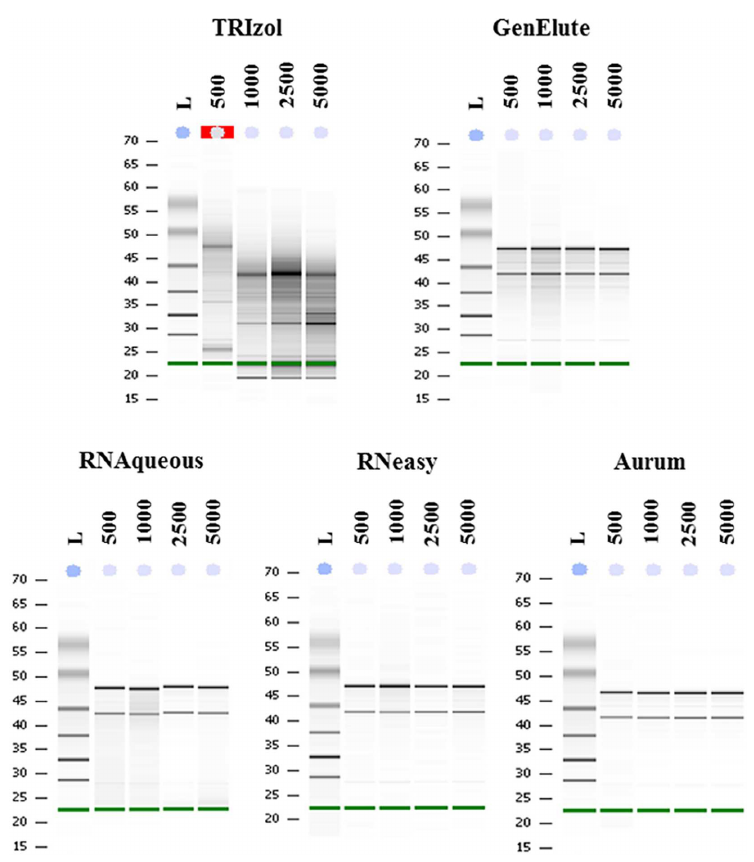
Fig 1. Bioanalyzer Agilent electrophoresis runs. Examplesof representativeBioanalyzer Agilent electrophoresis runs for the five different methodsappliedfor RNA extractions from P . lividus embryos: TRIzol, GenElute ™ MammalianTotal RNA MiniprepKit (Sigma-Aldrich), RNAqueous ® Micro Kit (Ambion from Life Technologies), RNeasy ® Micro Kit (Qiagen) and Aurum ™ Total RNA Mini Kit (Biorad). Four different numerical amounts of embryos were used for RNA extraction: 500, 1000, 2500 and 5000 embryos. The ladder(L) is reportedin the first laneof each run. The green bandat the bottom of each panel is the RNA 6000 Nano Marker (Agilent RNA 6000Nano Kit, Agilent Technologies, Inc.). Red box in the 500 lane of TRIzol indicatesthat the Bioanalyzersoftware cannot calculateRIN values (reportedas N/A in the Table 1) for this sample, becauseof very low concentration and high level of degradationof the